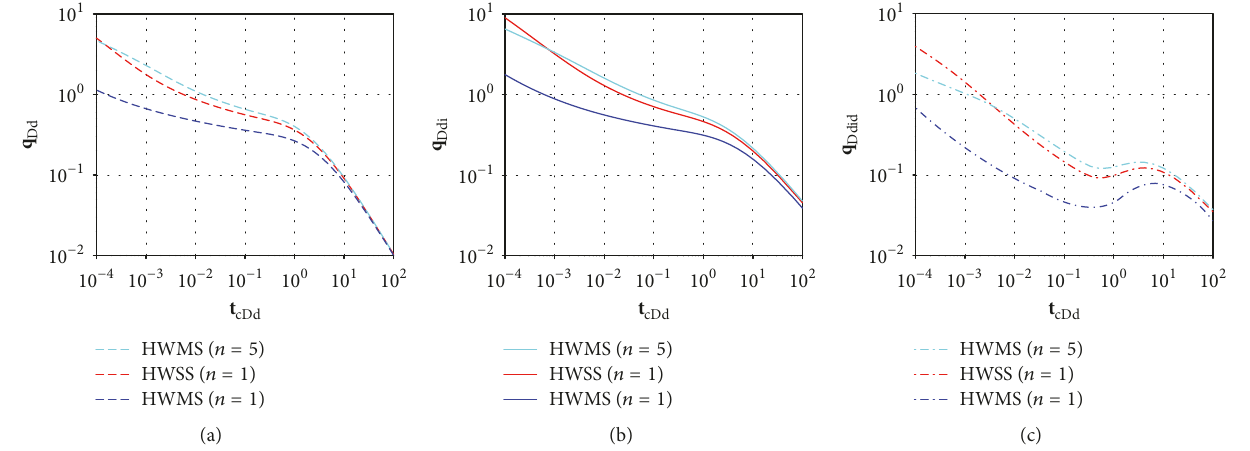
Figure 3: Blasingame type curve according to the solution of constant rate: (a) 𝑞 𝐷𝑑 ; (b) 𝑞 𝐷𝑑𝑖 ; (c) 𝑞 𝐷𝑑𝑖𝑑